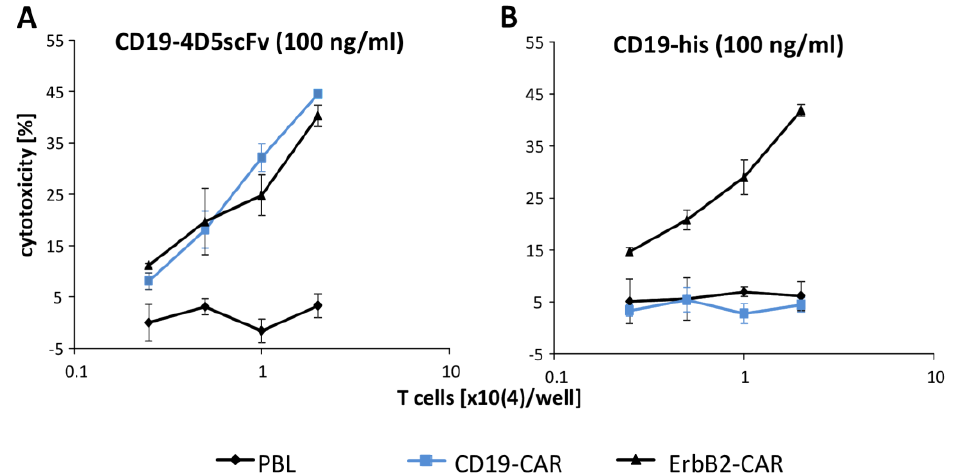
Figure 3. CD19-4D5scFv redirected the CD19-CAR T cells to kill the ErbB2 + tumor cells with the same efficiency as the ErbB2-CAR T cells. T cells were engineered with the CD19-CAR (blue lines) or ErbB2-CAR and the same numbers of CAR T cells (0.25–2 × 10 4 cells/well) were co-incubated for 18 h with the ErbB2 + SKOV-3 tumor cells (2 × 10 4 cells/well) in the presence of the CD19-4D5scFv ( A ) or CD19 fusion protein ( B ) for the control (100 ng/mL each). Non-transduced T cells also served as the control. Viability was determined by the XTT assay and the specific lysis was calculated. Values represent the mean of the triplicates ± SD.